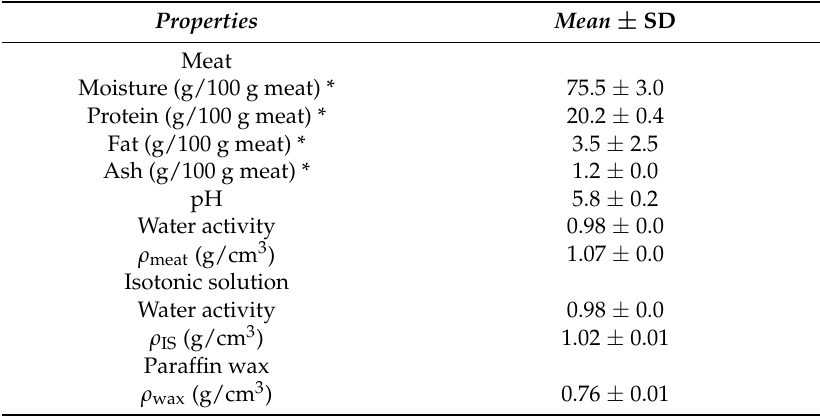
Table 1. Physical-Chemical Characteristics of Meat, Isotonic Solution and Paraffin Wax.